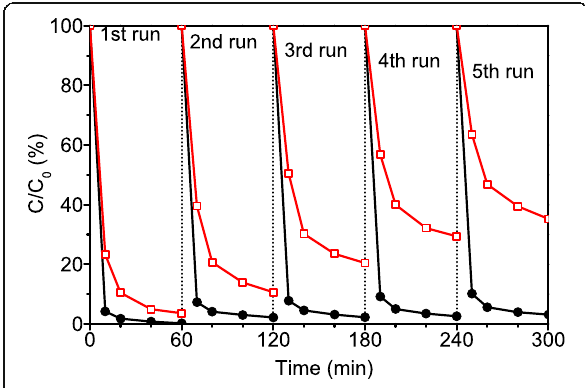
Fig. 5 Repeated photocatalytic degradation of RhB with Ag 3 PO 4 (red open squares) and ATP/TiO 2 /Ag 3 PO 4 ternary composites (black solid circles) under simulated solar irradiation